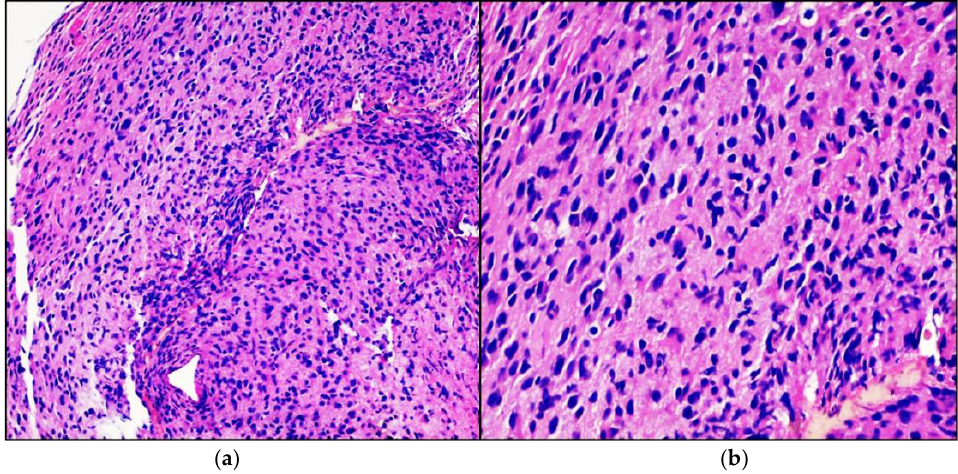
Figure 3. High-grade glioma. Hematoxylin-eosin-stained photomicrographs with original magnification 100× ( a ) and 200× ( b ) showing diffusely infiltrating cigar shaped neoplastic astrocytes with obvious nuclear atypia. On the strong suspicion of a genetically determined syndromic condition, the child was subjected to genetic investigation in search of mutations predisposing to cancer. DNA sequencing based on the canonical transcript NM_000546.5 showed an heterozygous mu- tation of exon 7 of TP53 gene: c.743G > A (p.Arg248Gln), confirming the diagnosis of LFS.